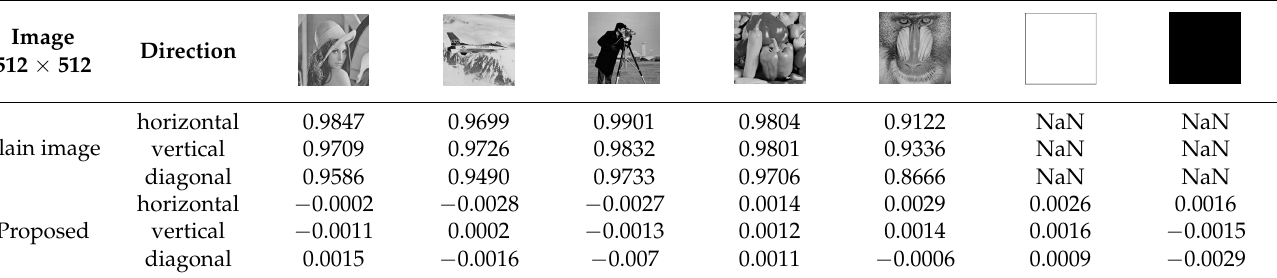
Table 4 lists the 𝑥 (cid:2870) values of the original image and the encrypted image and